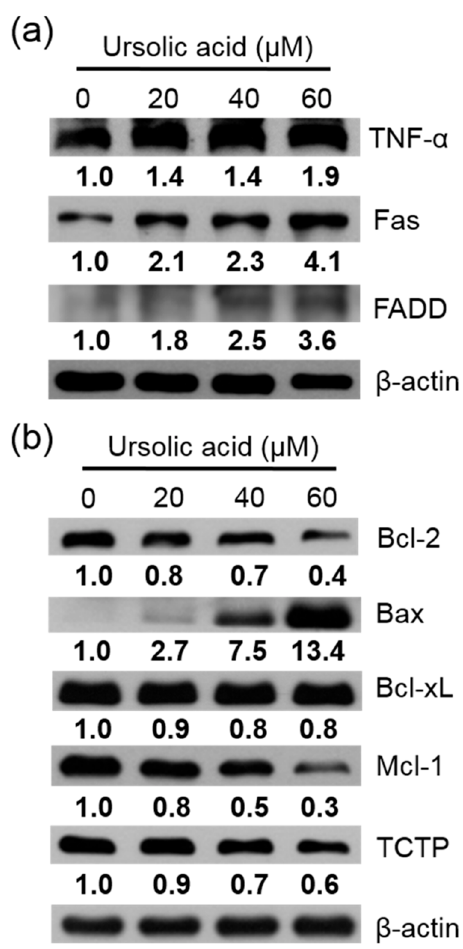
Figure 7. UA induced protein expression of in Huh-7 cells. ( a ) TNF- α , Fas, and FADD, ( b ) Bcl-2, Bax, Bcl-xL, Mcl-1, and TCTP. Huh-7 cells were treated with various doses of UA for 24 h. The expression of protein was evaluated using western blotting, and β -Actin was used as a loading control.